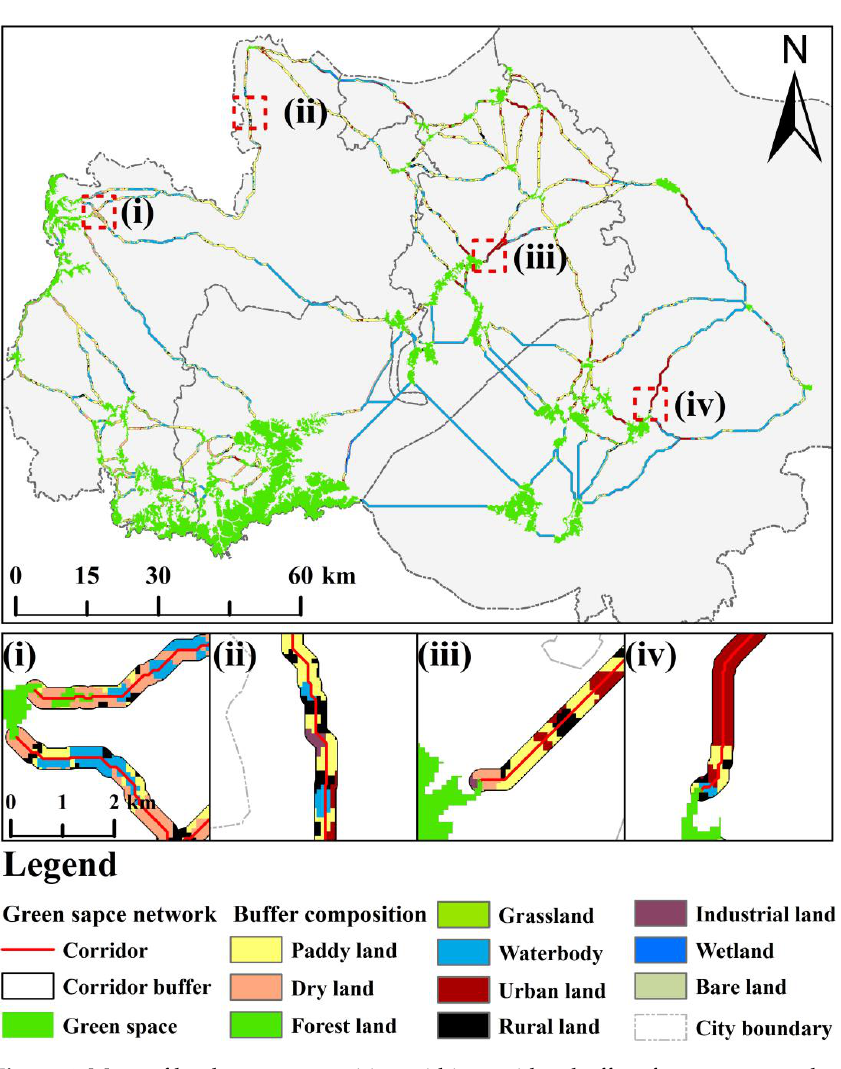
Figure 4. Maps of landscape composition within corridors buffer of greenspace ecological networks (GENs). The sub-figure ( i – iv ) shows the detailed land use/land cover composited the buffer areas.